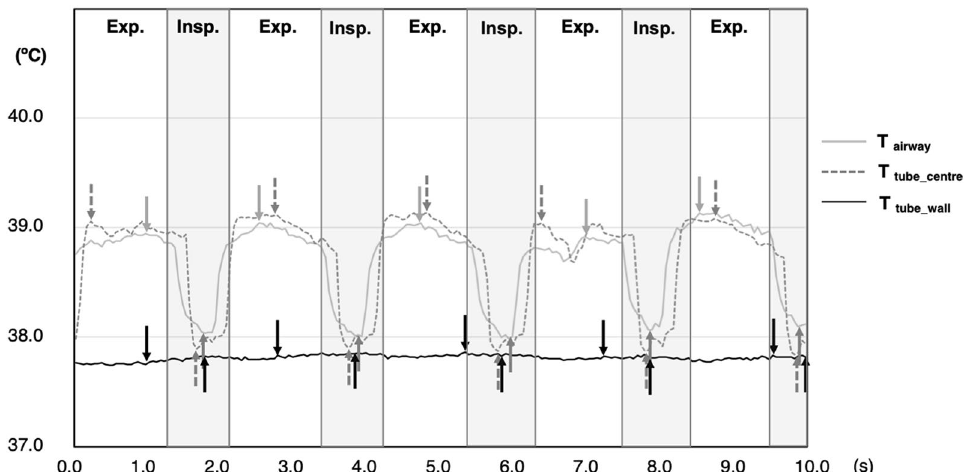
Figure 1. Representative time-trend data of respiratory gas temperatures. A representative waveform recorded with the following ventilator settings: respiratory rate, 30/min; peak airway pressure, 15 cmH 2 O; inspiratory time, 0.5 s; positive end-expiratory pressure, 5 cmH 2 O; and with inflating the endotracheal tube cuff. T airway and